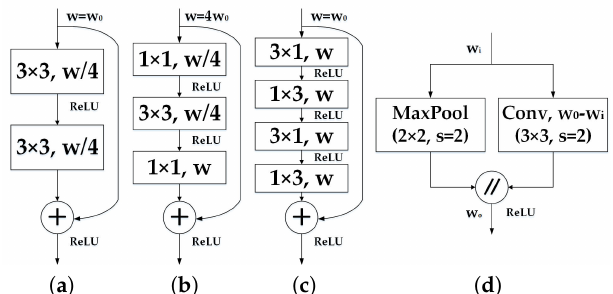
Figure 6. Depiction of the residual layers and the down-sampler block: ( a ) non-bottleneck, ( b ) bottleneck, ( c ) the proposed non-bottleneck-1D and ( d ) down-sampler block. w : width of the convolution, representing the number of feature maps, s :